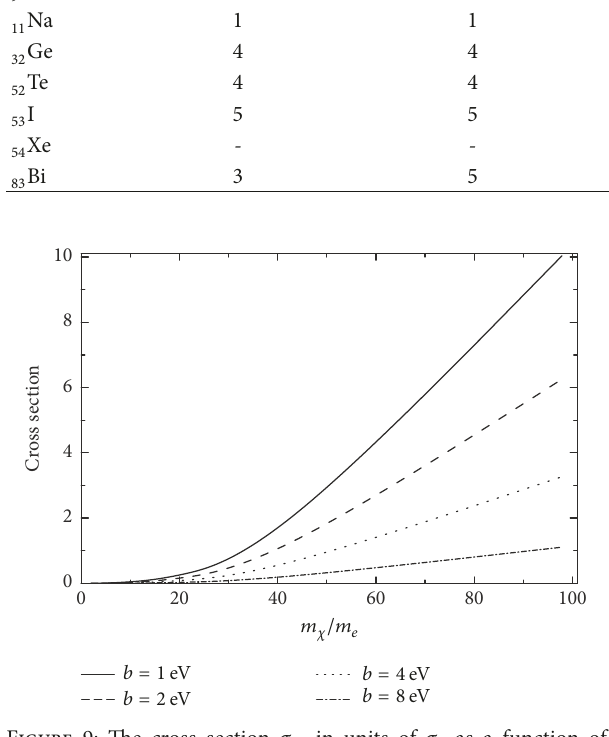
Figure 9: The cross section 𝜎 av in units of 𝜎 0 as a function of 𝑥 = 𝑚 /𝑚 𝑏 = 1,2, 4 , and 8eV increasing 𝜒 𝑒 for binding energies downwards (the curve for 𝑏 = 10 is not